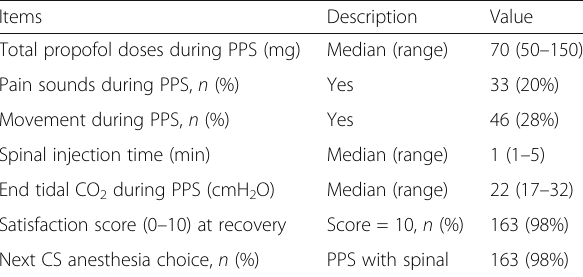
Table 4 Data of propofol procedural sedation (PPS) in